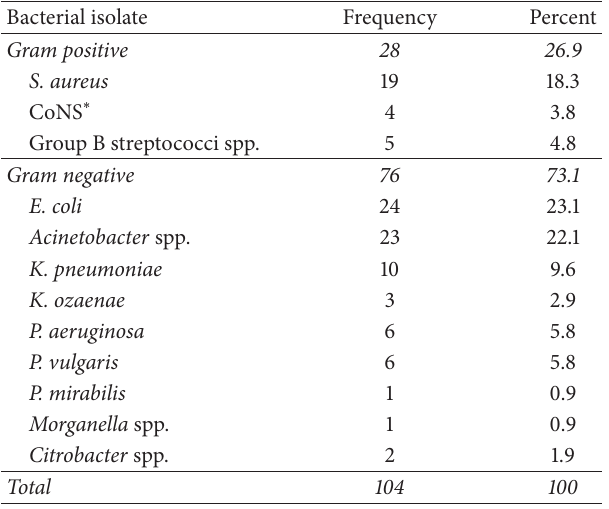
∗ CoNS: coagulase negative staphylococci; spp.: